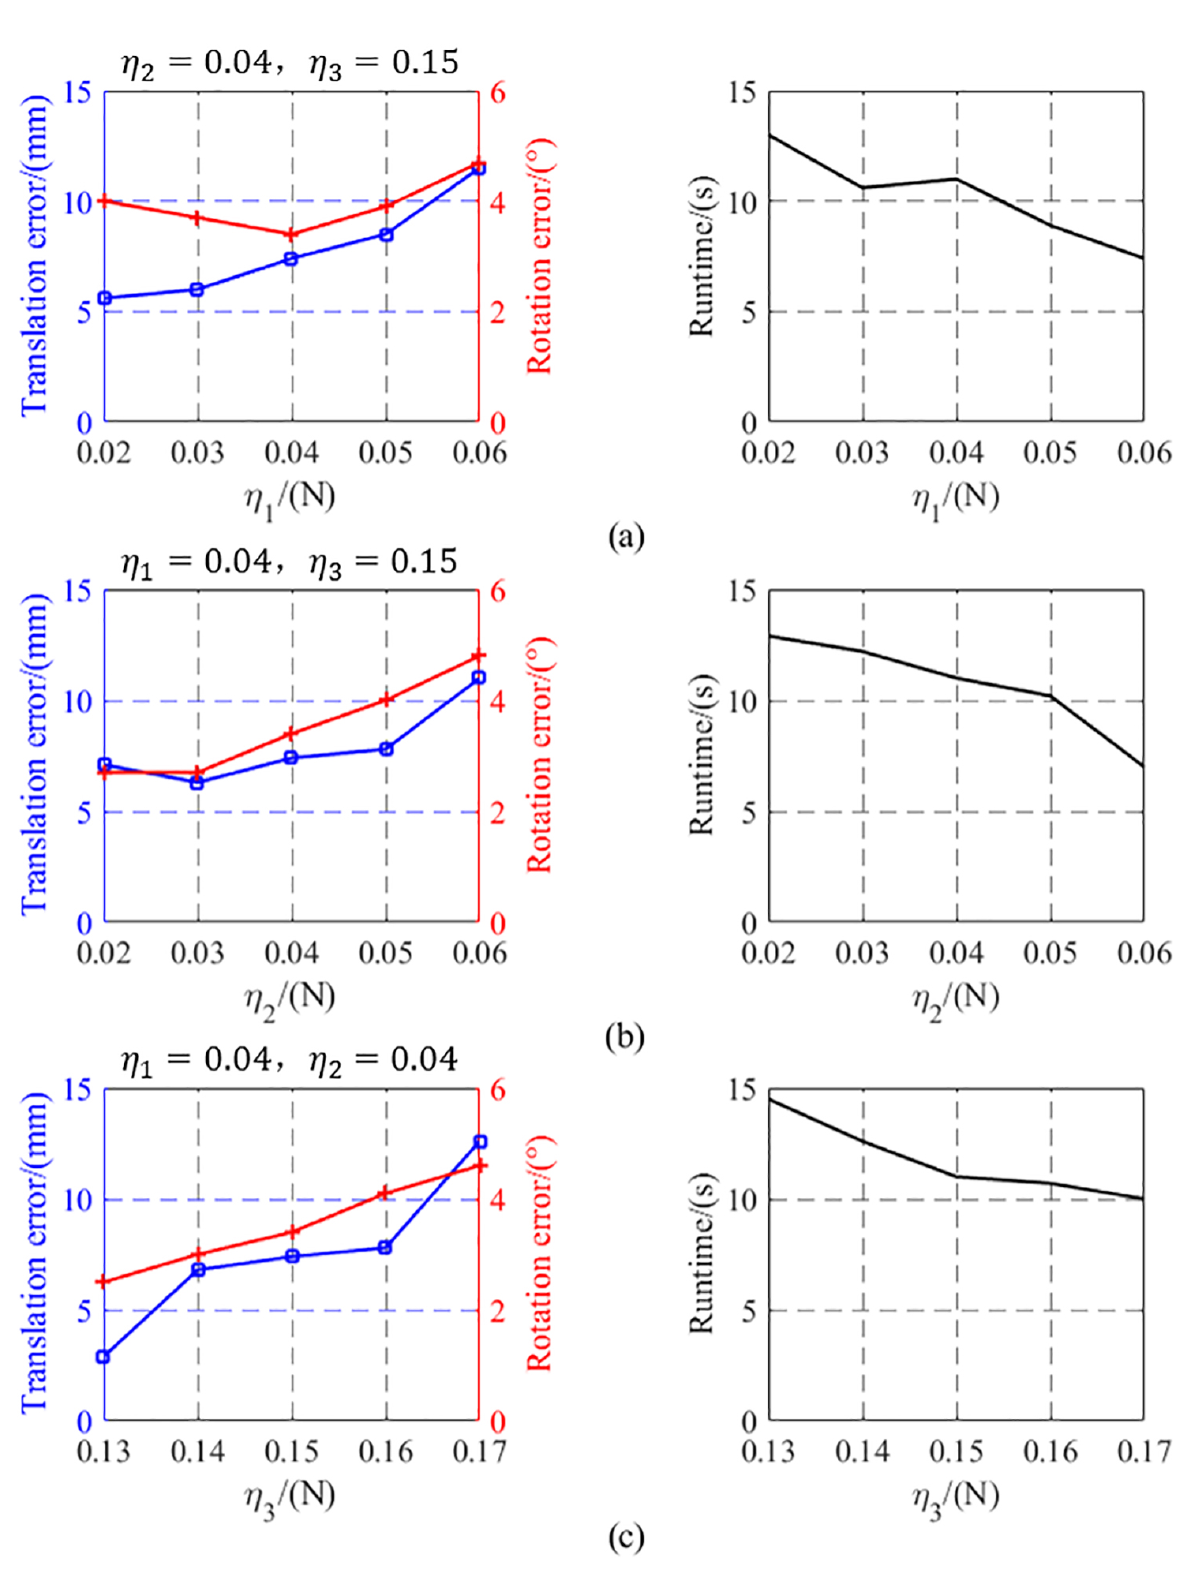
Figure 14. Translational error, rotational error, and runtime of each error analysis experiment. ( a ): η 2 = 0.04, η 3 = 0.15 and η 1 is the variable. ( b ): η 1 = 0.04, η 3 = 0.15 and η 2 is the variable. ( c ): η 1 = 0.04, η 2 = 0.04 and η 3 is the